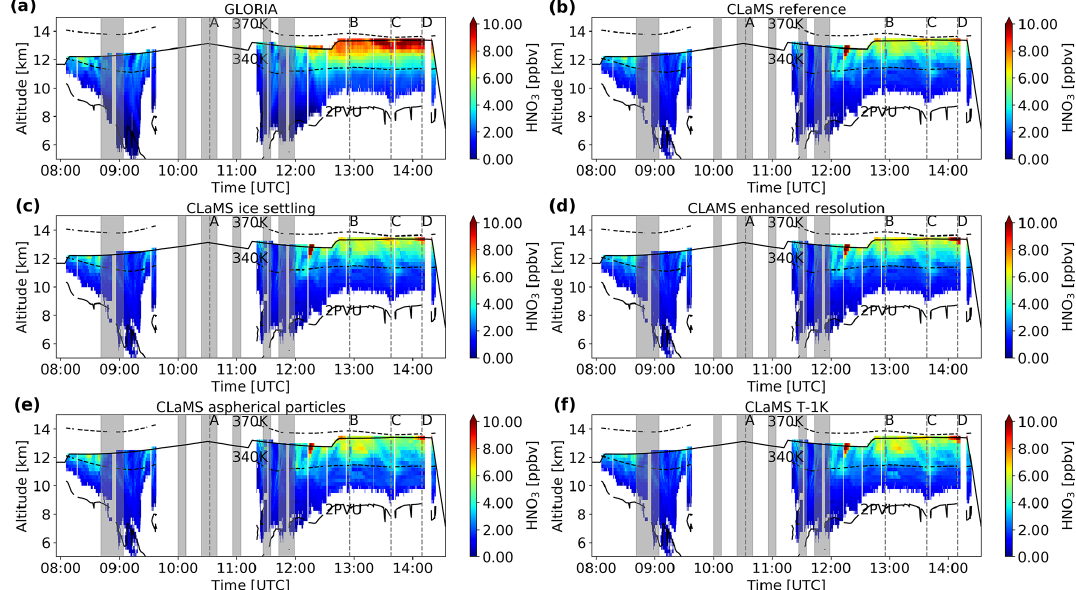
Figure B3. Cross sections of HNO 3 volume mixing ratio distribution for flight 12 on 31 January 2016 derived by GLORIA (a) and modelled by the CLaMS reference simulation (b) , and sensitivity simulations considering (c) ice formation on NAT particles, (d) temperature fluctua- tions, (e) growth rates of aspherical particles and (f) 1K global temperature offset. Flight altitude (bold black line), characteristic waypoints (A, B, C, D), 340 and 370K potential temperature levels (MERRA-2, dashed black lines), and 2PVU level (MERRA-2, black line). Please note the changed colour bar compared to Figs. B1, B2, B4.